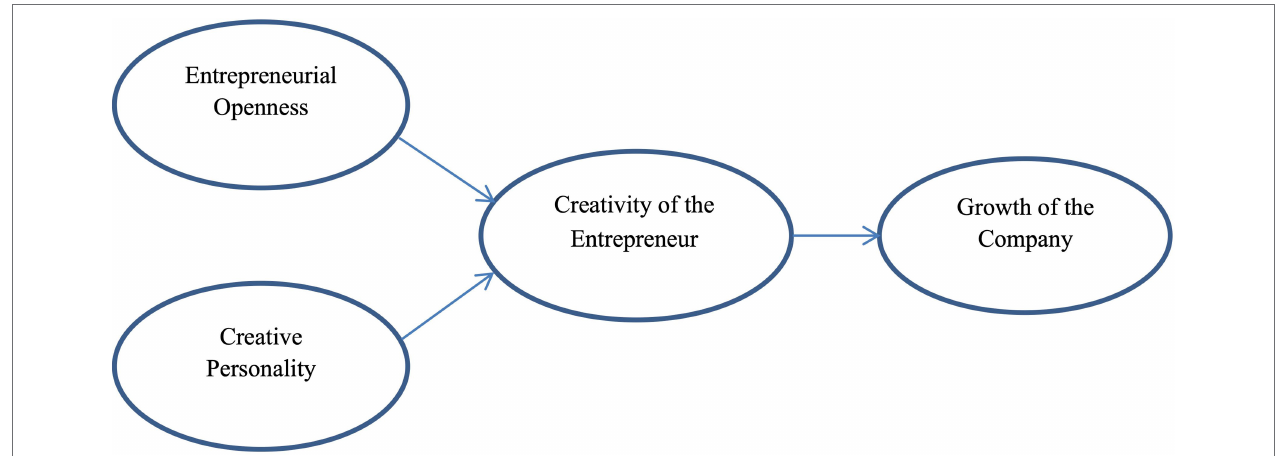
FIGURE 1 | The model of entrepreneurial openness, creativity of the entrepreneur, and growth of the company.